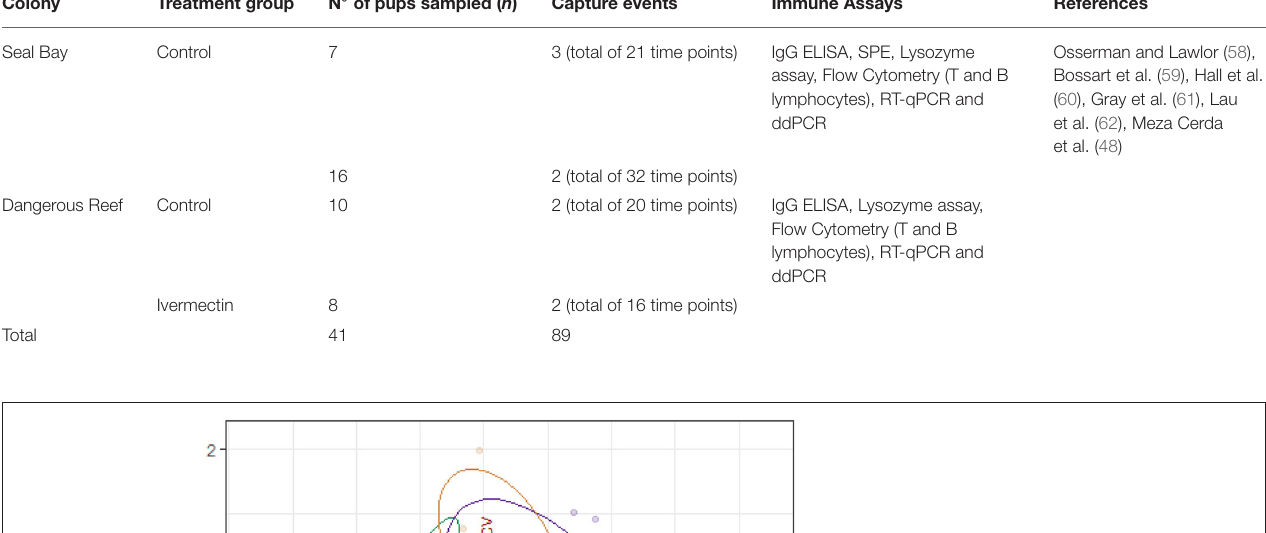
TABLE 1 | Summary of samples size ( n ) and immune measures used in this study. Colony